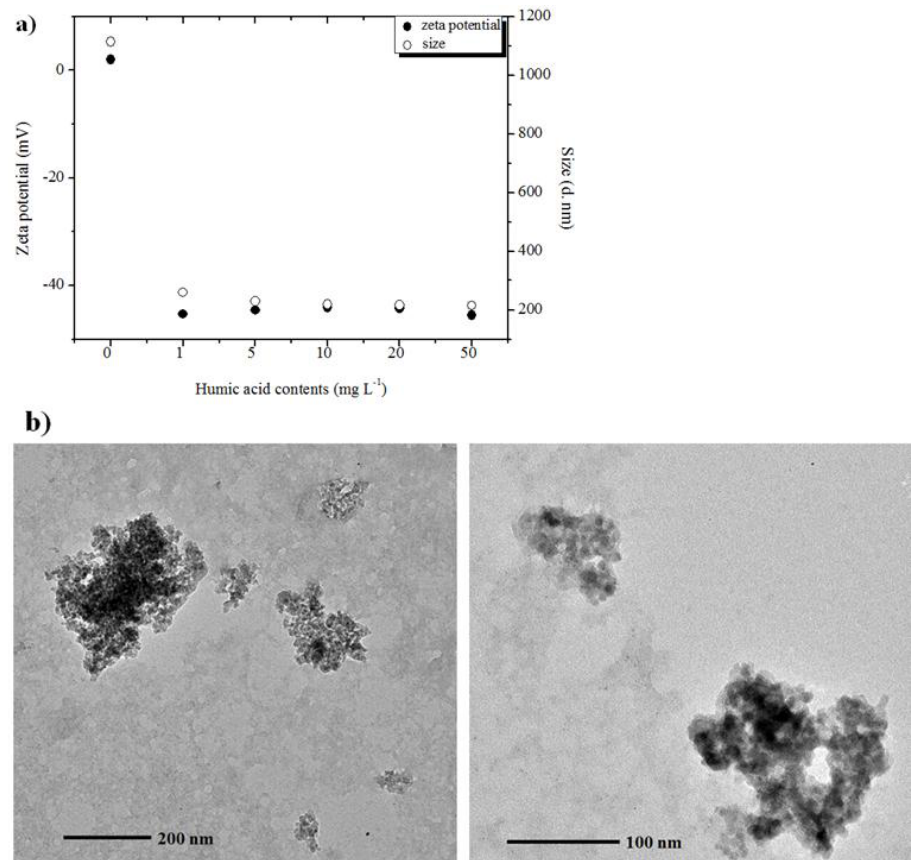
Figure 5. ( a ) Z ave hydrodynamic diameter ( ○ ) and ζ potential (●) of 10 nm of γ-Al 2 O 3 NPs as a function of HA concentration at pH close to the point of zero charge (PZC) of Al 2 O 3 ; and ( b ) bright field TEM images of 10 nm γ-Al 2 O 3 NPs with 10 mg·L −1 of HA at pH close to PZC of Al 2 O 3 .